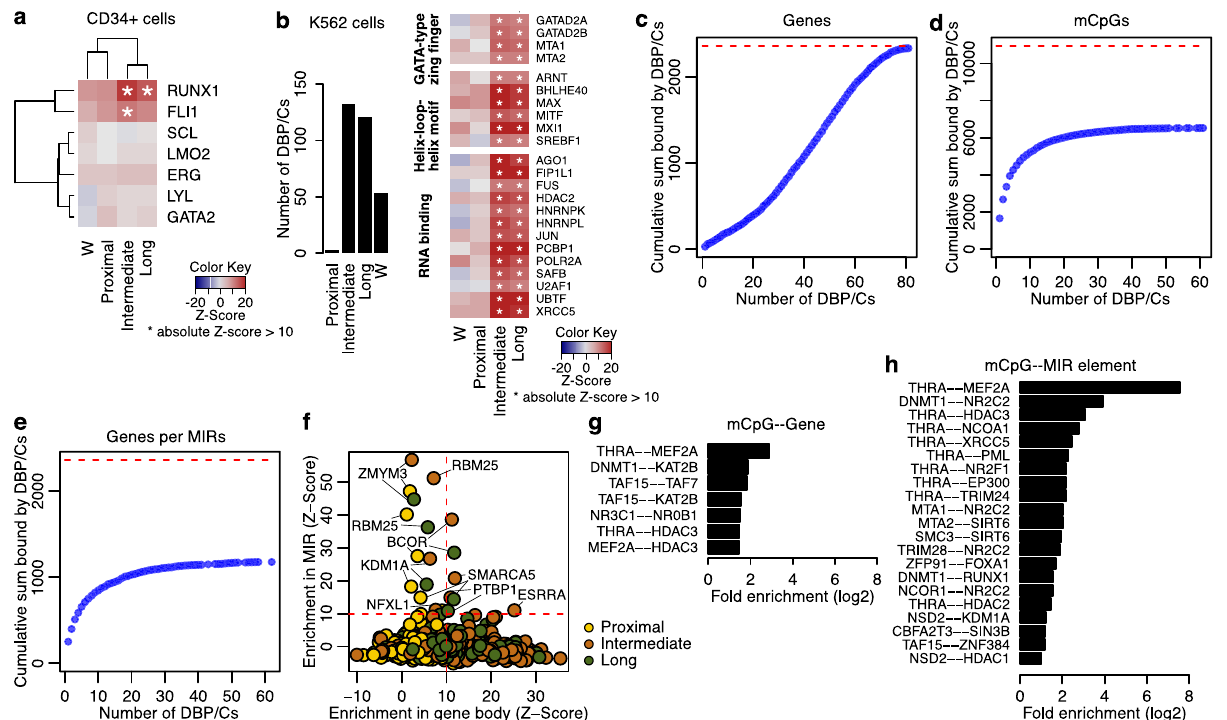
Fig.3|EnrichmentofDNA-bindingproteinsandmultiproteincomplexes(DBP/ Cs) in genes with intermediate- and long-range correlations. a Heatmaps showing the enrichment/depletion of transcription factor binding in CD34 + cells. The value represents the Z -score of the observed overlap of ChIP-seq peaks with reference to a simulated expected distribution (see Methods for details). Asterisks indicateanabsolute Z -scoregreaterthan10. b BarplotshowingthenumberofDBP/ Cs from ENCODE signi fi cantly enriched ( Z -score >10) in each gene set. Heatmap showing the enrichment/depletion of selected DBP/Cs from ENCODE enriched in the genes with intermediate- and long-range correlations but not in the ones with proximal correlations. Asterisks and notations are same as in a . c , d Plots showing the number of genes ( c ), mCpGs ( d ) or genes containing at least one MIR element ( e ) that are bound by up to N transcription factors ( x axis). This is shown in a cumulative manner, e.g., up to 20 DBP/Cs bind a total of 393 unique genes with